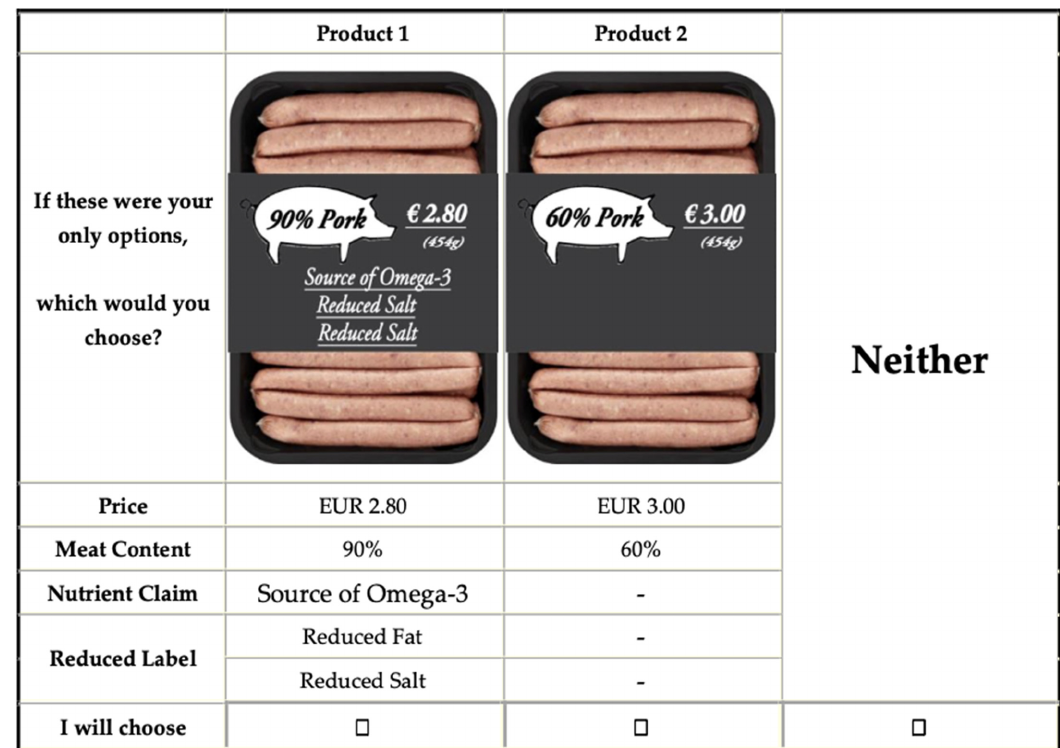
Figure A11. Choice set 11 in the questionnaire